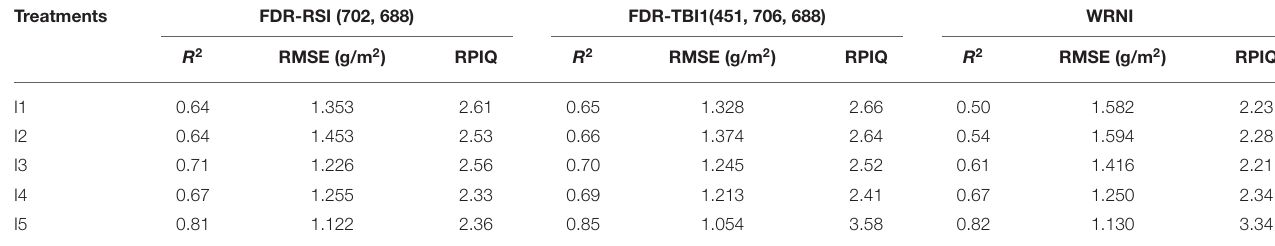
TABLE 5 | Relationships between spectral indices and leaf nitrogen accumulation under different irrigation regimes.